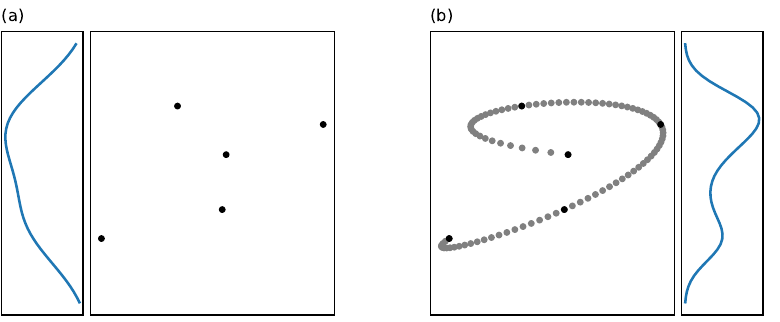
Figure 5. ( a ) Five observations of independent variables. The outer panel shows the probability density of the y variable given by Gaussian kernel density estimation, with zero along the inner edge. The estimated density is smooth. ( b ) Polynomial interpolation through the points creates a pattern. Marginal density has peaks as the estimator bandwidth is smaller. Default bandwidth selection of SciPy was